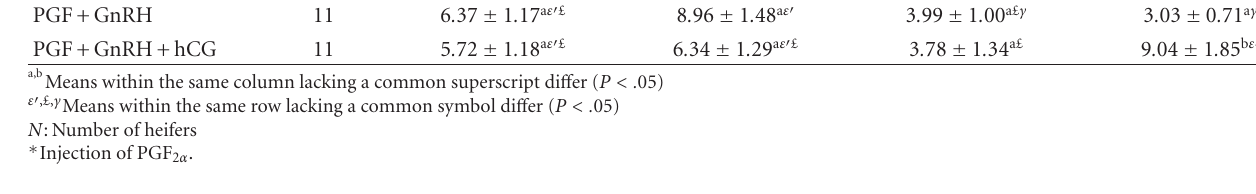
Table 3: Number ovulations by treatment and by